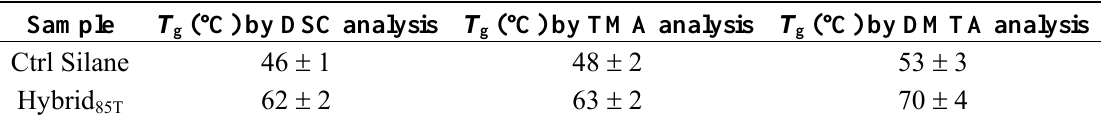
values measured on dual-cured Ctrl Silane and Hybrid Table 3. T g different techniques. DSC, TMA, DMTA, dynamical mechanical